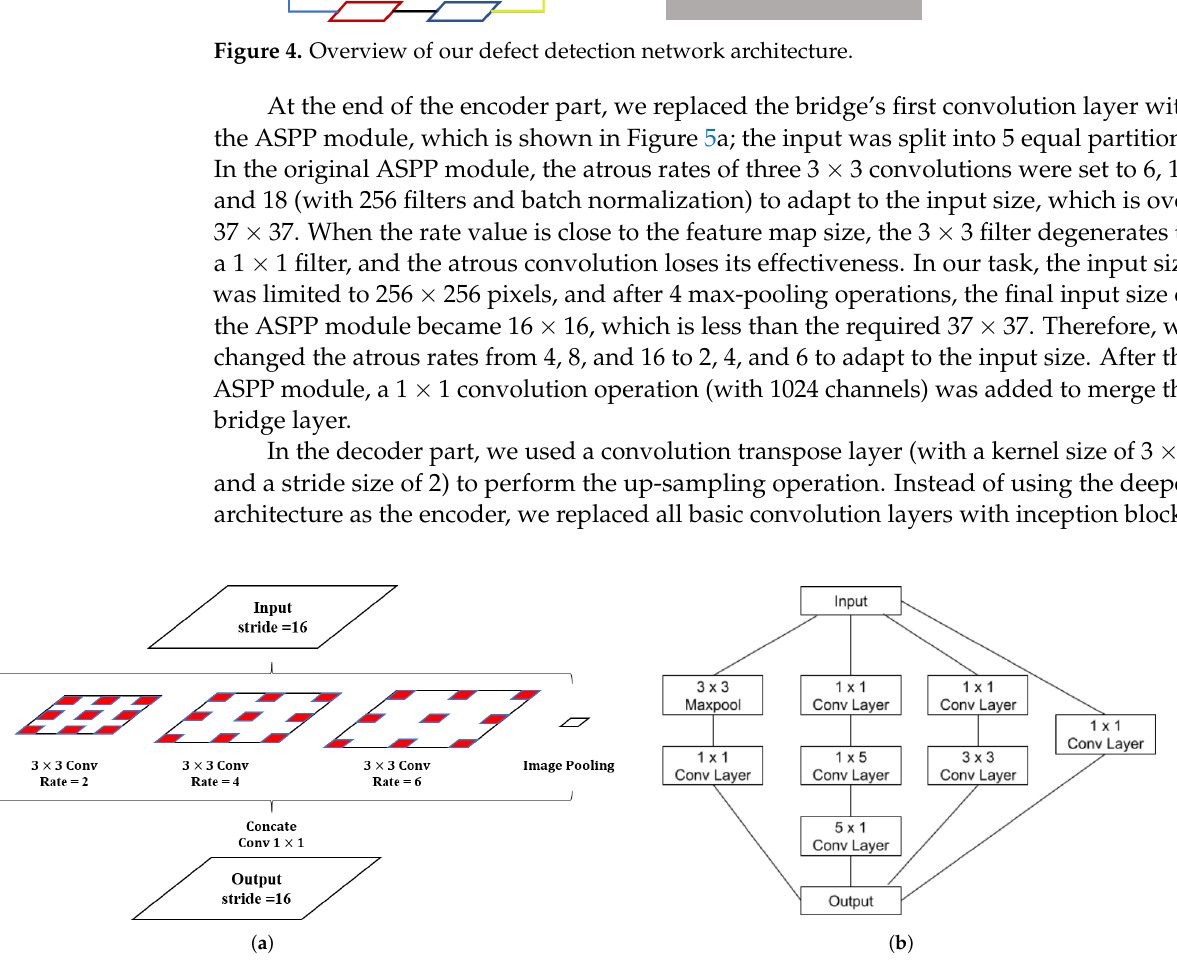
Figure 5. Modules introduced in our method. ( a ) represents the architecture of ASPP module and ( b ) represents the inception